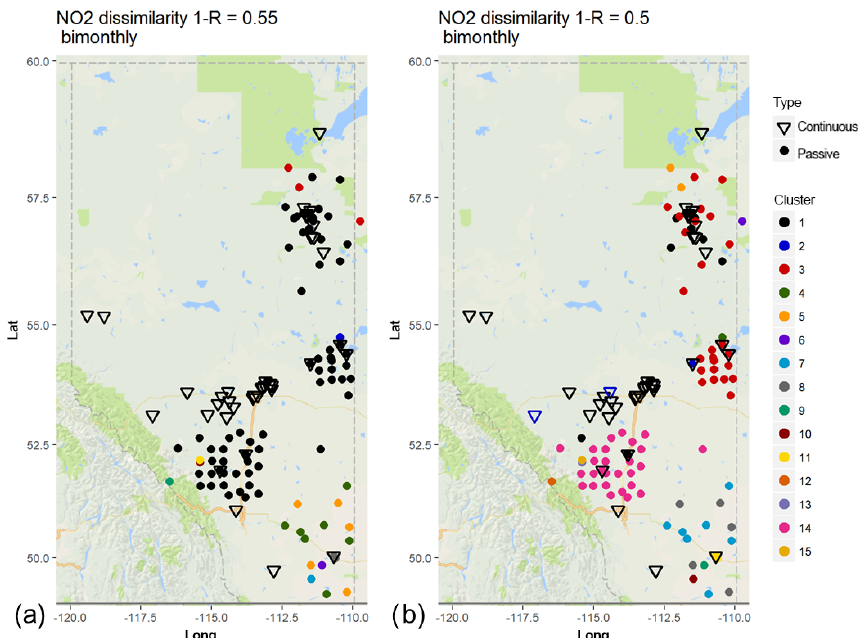
Figure 5. Associativity analysis for passive and continuous bimonthly NO 2 averages for 1 − R = 0.55 ( R = 0.3) Stations are colour-coded according to cluster formation, with continuous stations are marked as inverted triangles and passive stations as circles. The acronyms for the airsheds are as in Fig.